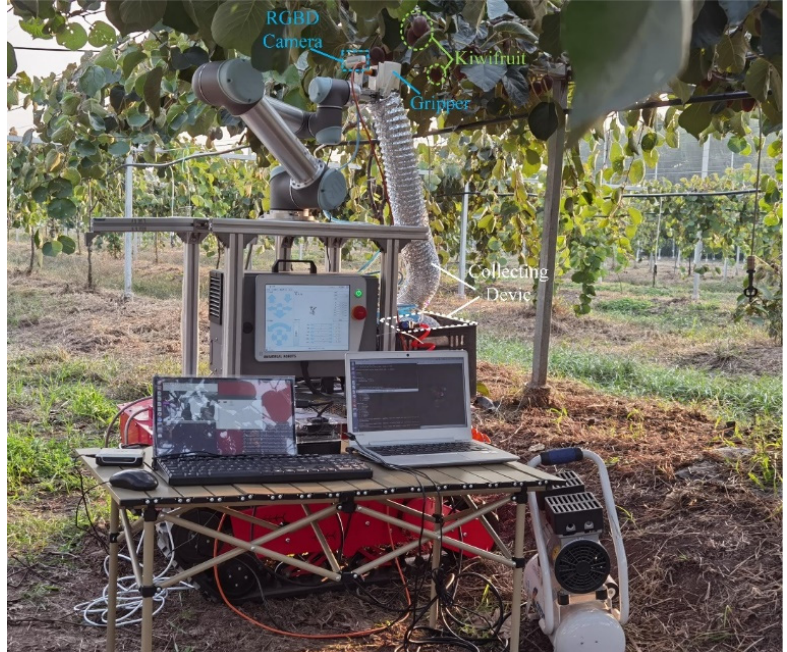
Figure 11. Structure of harvesting robot.